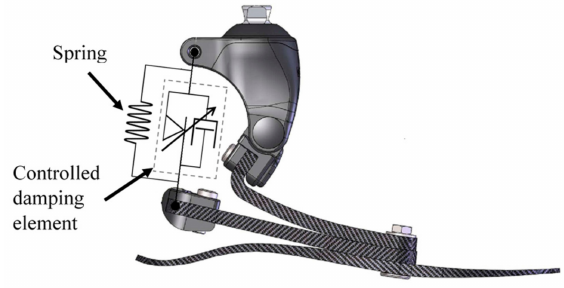
Figure7. Schematicrepresentationofthelinearspringandactivedampingelementoverthetranslational joint defined in the FE